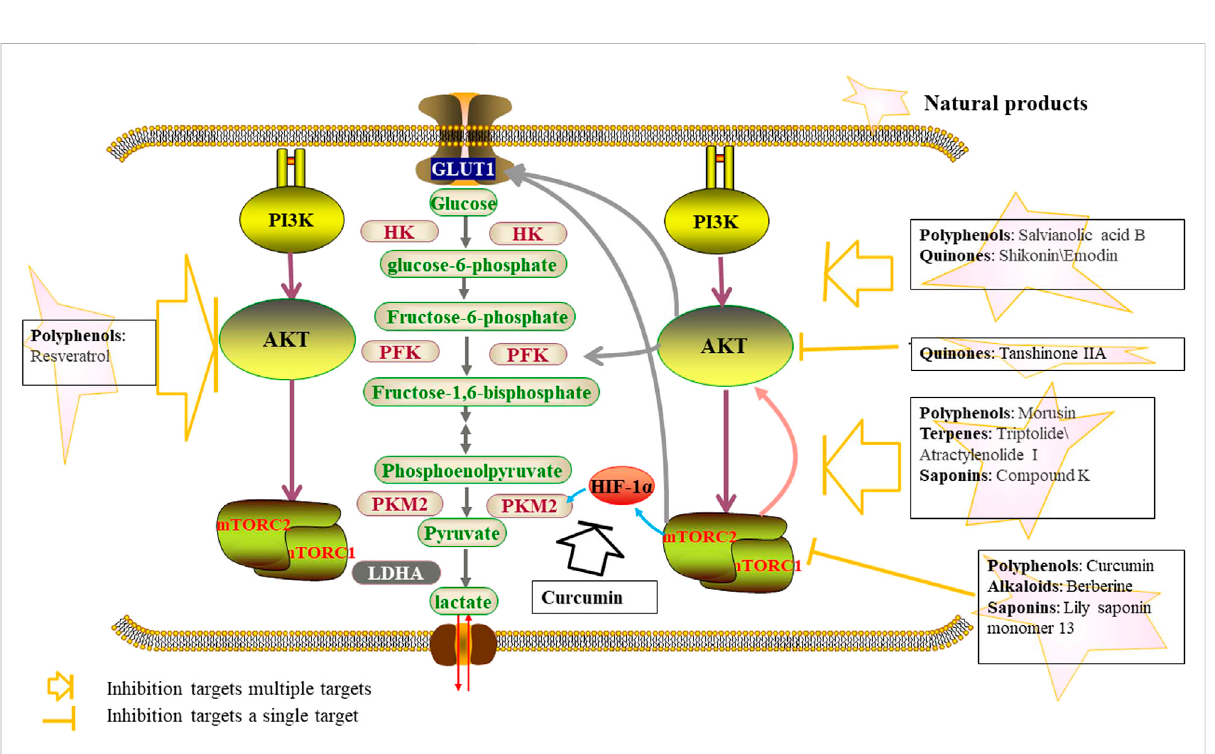
FIGURE 3 Natural products inhibit glycolysis through the PI3K-AKT-mTOR